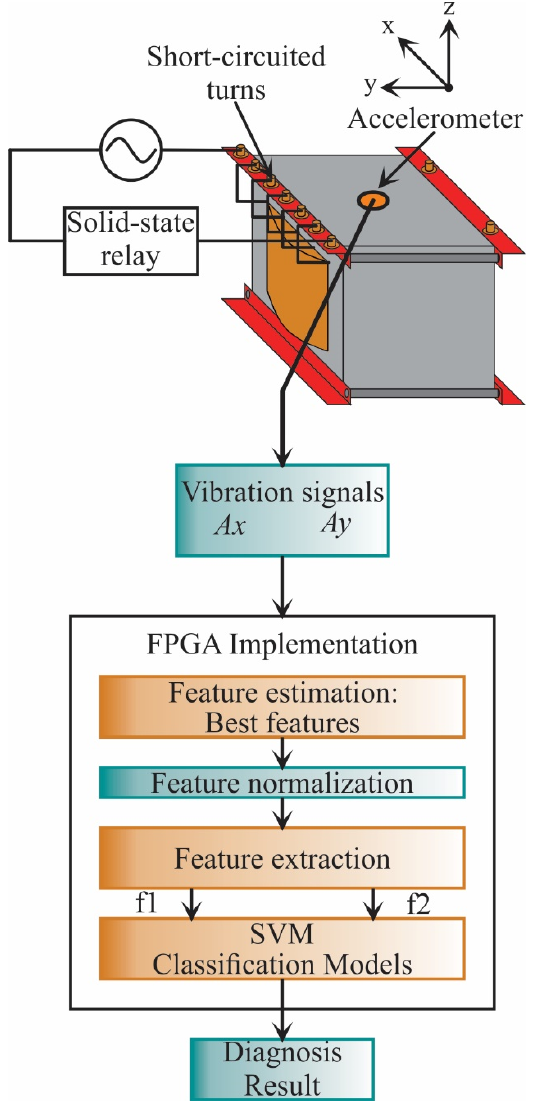
Figure 5. Flowchart for the proposed methodology during the implementation stage.